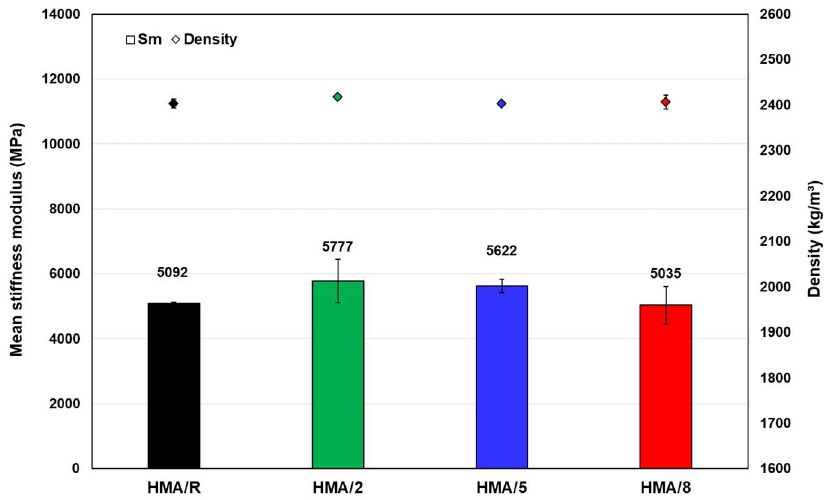
Figure 6. Stiffness modulus at 20 °C for all the studied mixtures.